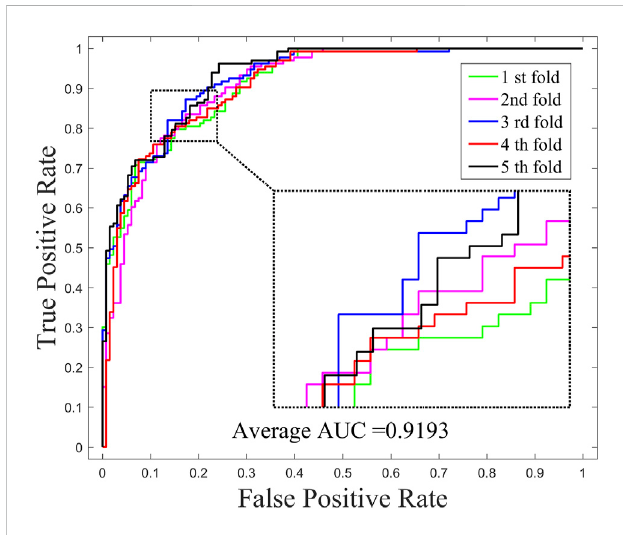
FIGURE 2 The ROC curves of GNMFDMA for drug-miRNA association prediction under